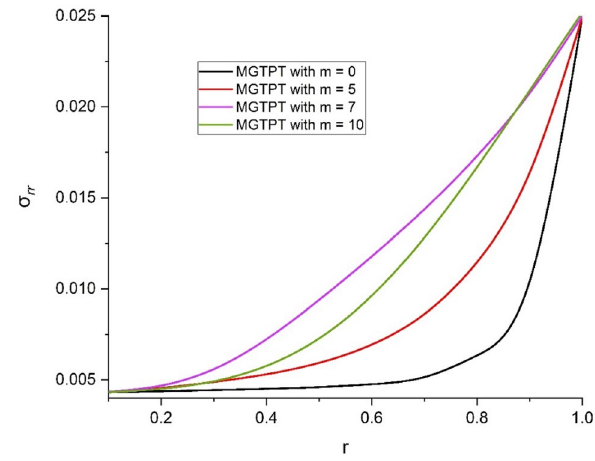
Fig. 5 The variation in radial stress with Hall Effect under MGTPT